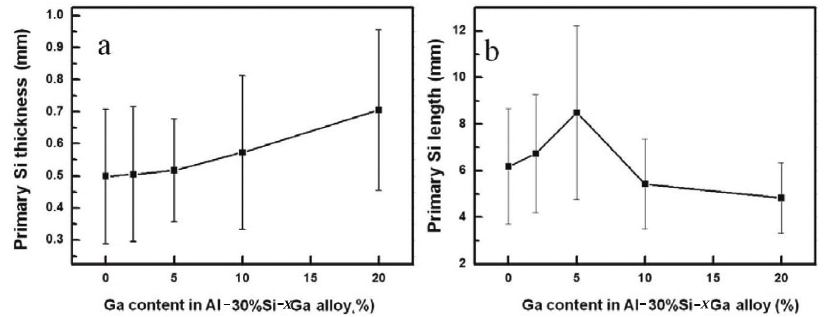
Figure 6: Plate thickness and length of primary Si as a function of Ga content (a) thickness, (b)